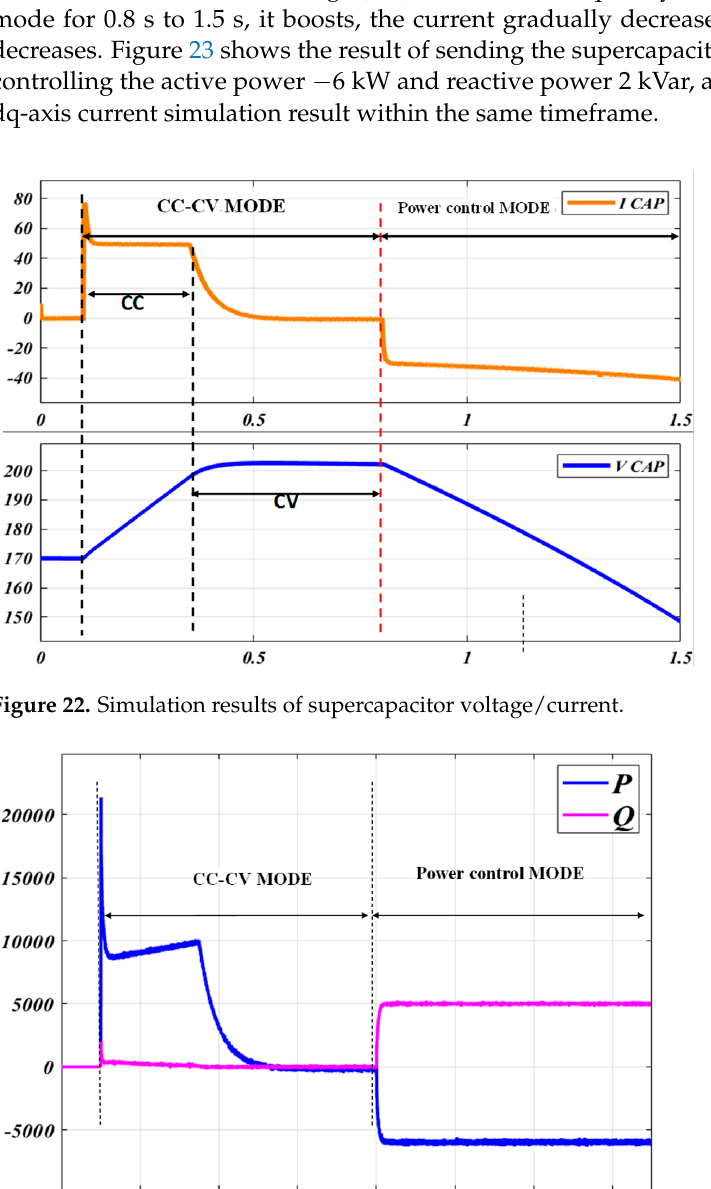
Figure 24. Simulation results of dq axis current.